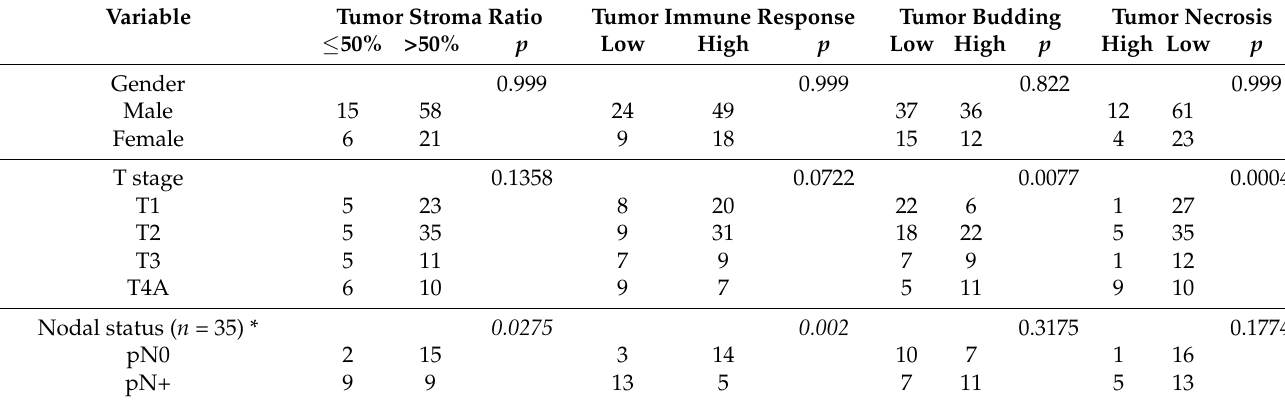
Table 2. Correlation analysis between histological features and clinicopathological characteristics in SCC.